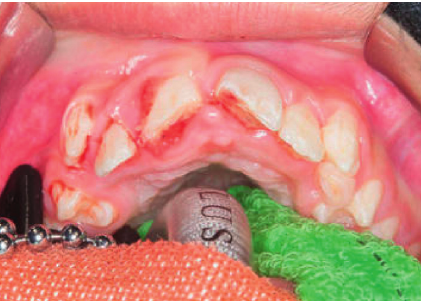
Figure 1: Initial presentation of dental trauma showing a 3mm intrusion of the UR1 and a complicated mesial incisal fracture of the